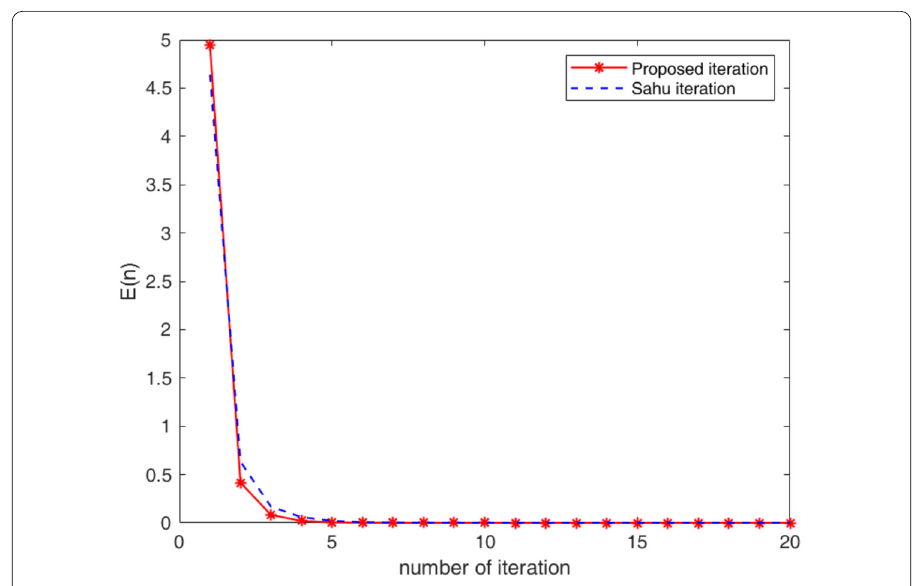
Figure 3 E ( n ) = (cid:16) χ n – χ n +1 (cid:16) for iteration with initial point